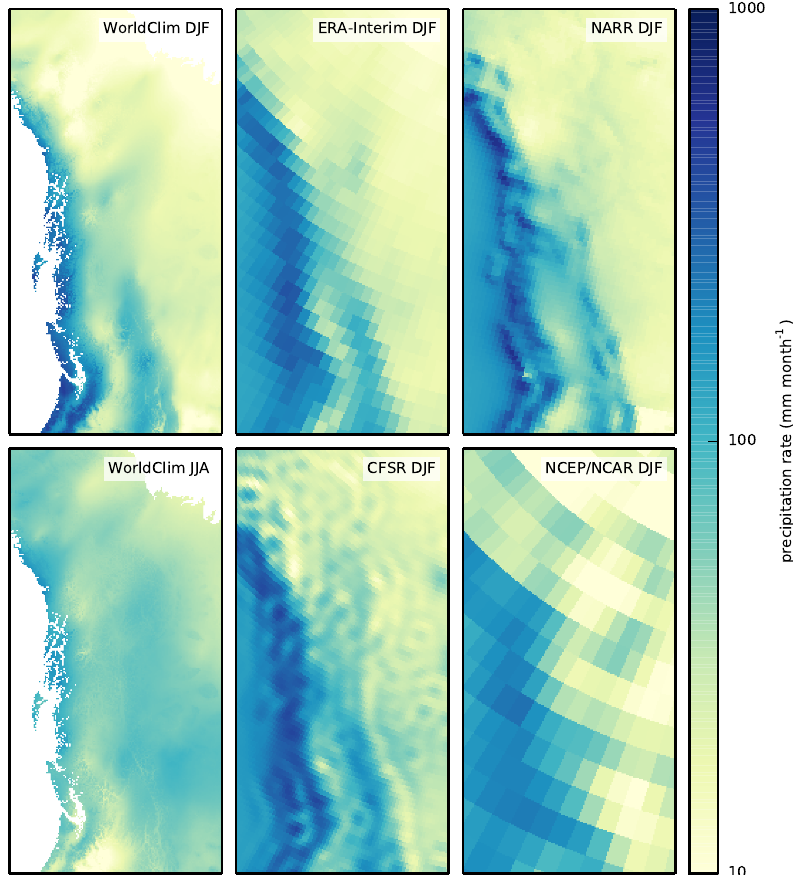
Figure 4. Winter (DJF) and summer (JJA) precipitation maps from WorldClim (Hijmans et al., 2005), and winter (DFJ) precipitation maps from ERA-Interim reanalysis (Dee et al., 2011), North American Regional Reanalysis (NARR; Mesinger et al., 2006), Climate Forecast System Reanalysis (CFSR; Saha et al., 2010), and NCEP/NCAR reanalysis (Kalnay et al., 1996) climatologies. Additional forcing data was prepared to correct for wave-like precipitation artefacts in CFSR (Sect.